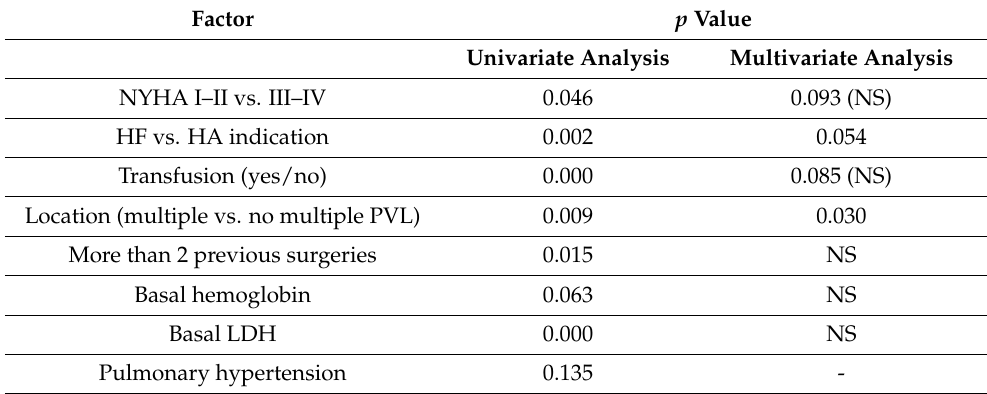
Table 3. Predictors of procedural